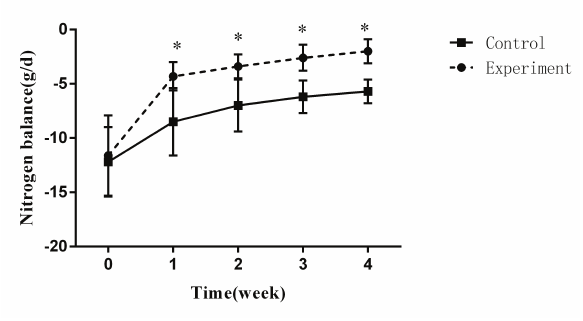
Figure 2: The Nitrogen balance comparison of the two